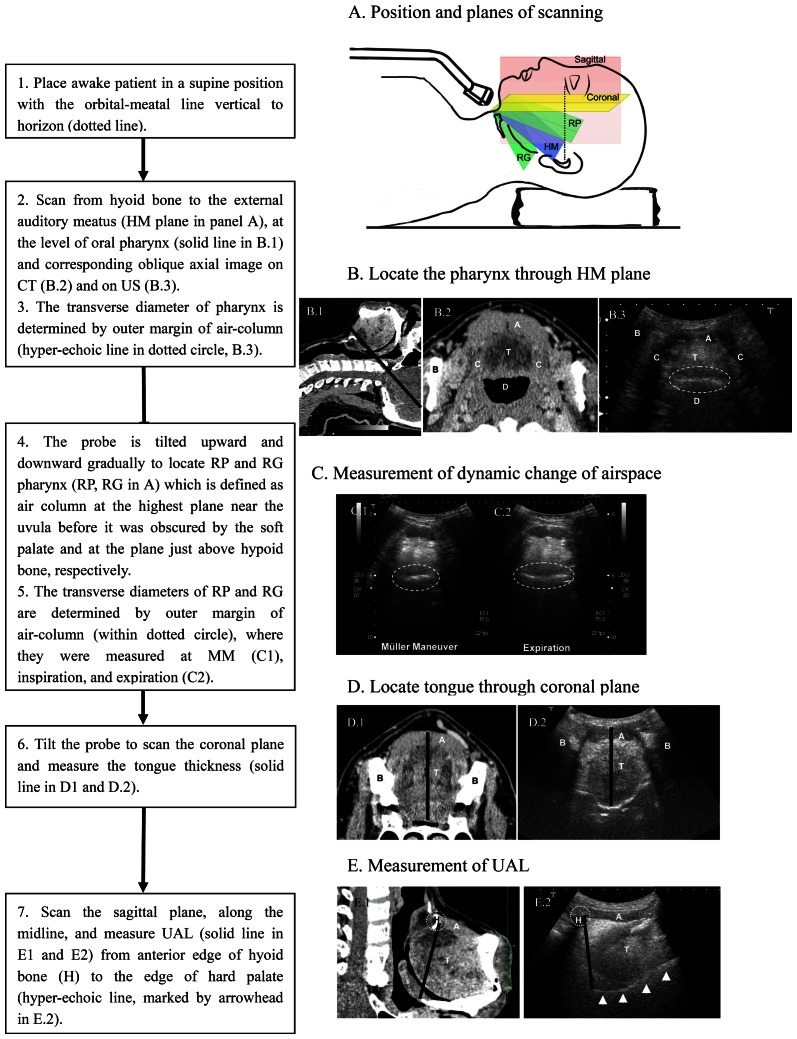
Protocol for sub-mental scanning.The procedure on ultrasound scanning is shown on the left panel and the corresponding computed tomography and ultrasonographic images on the right panel. A, Geniohyoid muscle; B, ramus of the mandible; C, hypoglossal muscle and corresponding acoustic shadow; D, airspace; H, hyoid bone and its acoustic shadow; T, tongue; HM, hyoid-external-meatus; RG, retro-glossal; RP, retro-palatal; UAL, upper airway length.